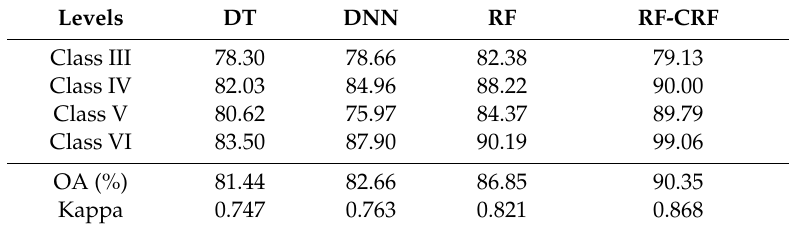
Table 8. Comparison of the di ff erent classification accuracy results (%) for the Huangshi dataset.